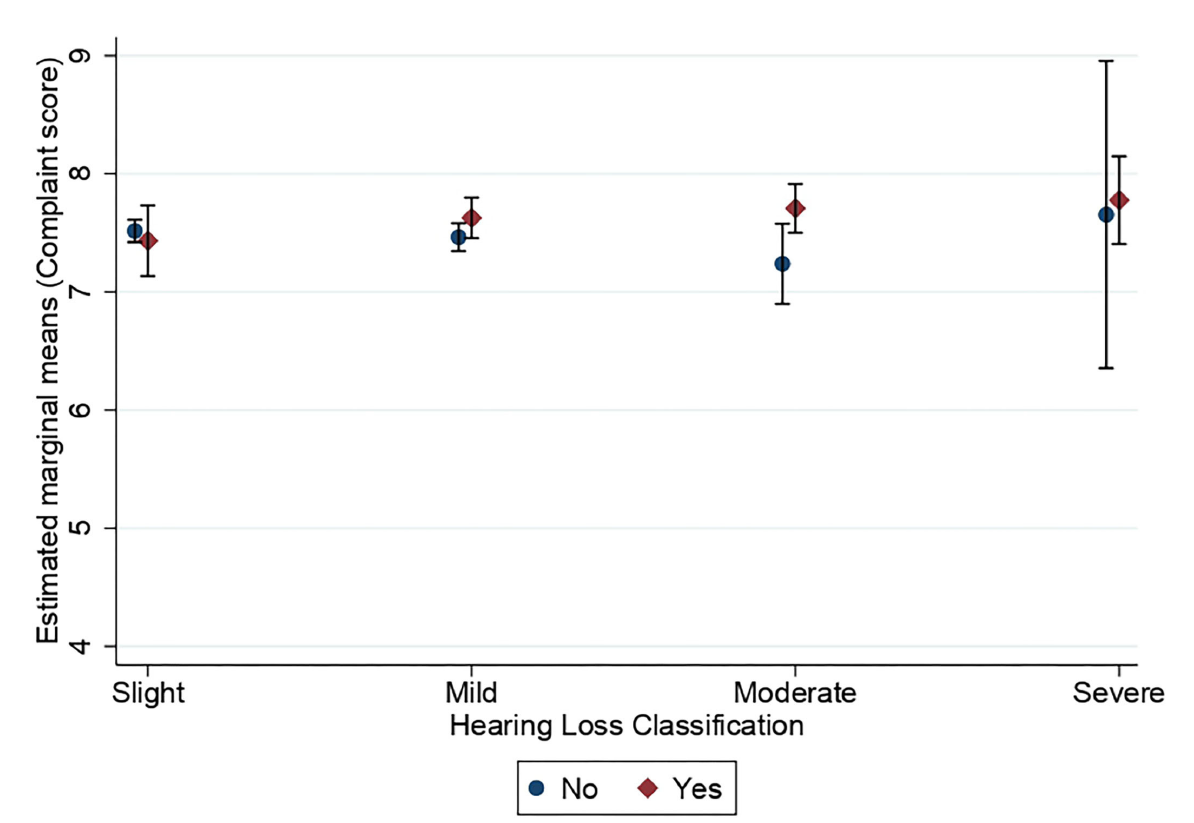
FIGURE3 Estimated marginal means of subjective long-term memory complaints as a function of hearing status and the use of hearing aids. Estimates are averaged over the levels of age at the means of the covariates sex, education, stroke, diabetes, smoking, and hospital admission for a head injury. The error bars indicate 95% confidence